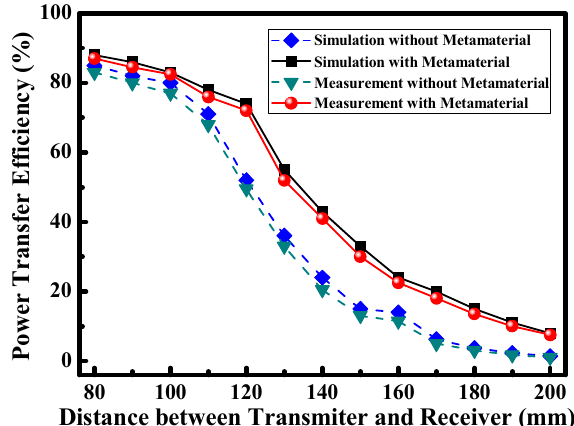
Figure 11. PTE of the wireless power transfer system at the different transmission distance with and without